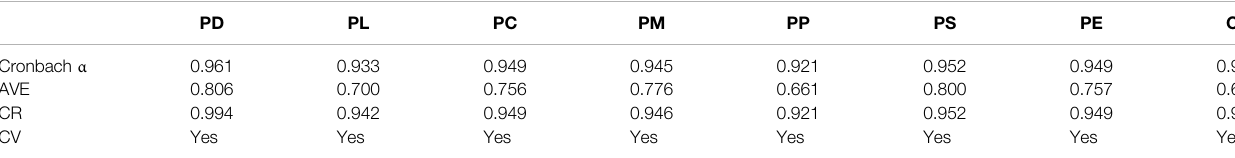
TABLE 8 | AVE and CR for constructs in the customer survey.